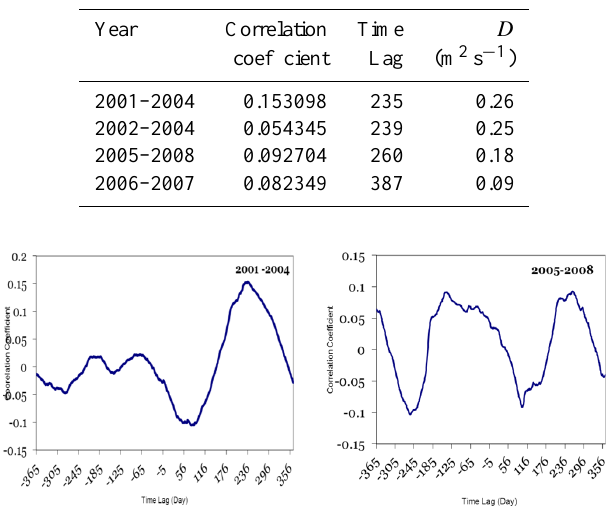
Fig. 6. Cross correlation between the reservoir water level and the seismicity of the region (a) 2001–2004 (b) 2005–2008.